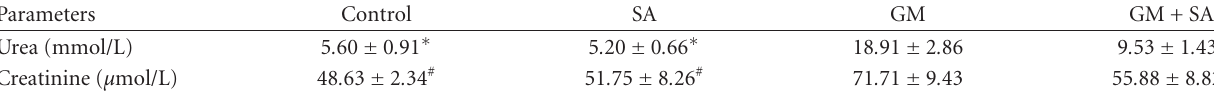
Table 1: E ff ects of salicylic acid on gentamicin-induced renal dysfunction as measured by levels of serum urea and creatinine.